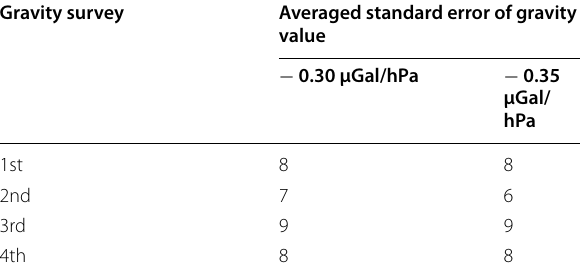
Table 2 Standard errors of point gravity values (in μGal) based on two gravity‑atmospheric admittance